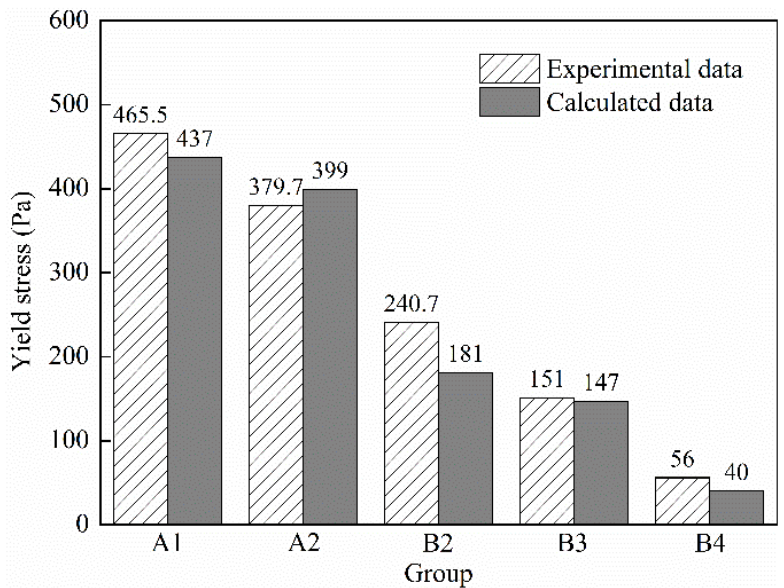
Figure 12. Comparison between calculated data and experimental data of yield stress.